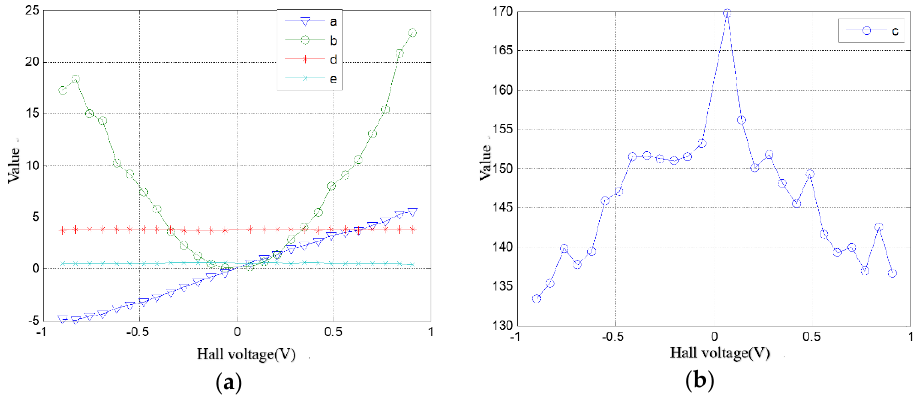
Figure 4. The curves of each ellipsoid equation parameter taking Hall sensor output voltage V Hall as an independent variable: ( a ) the curves of a , b , d , e ; ( b ) The curve of c. Table 1. The ellipsoid equation parameters and mean square error of the coordinates of the equivalent voltage points.